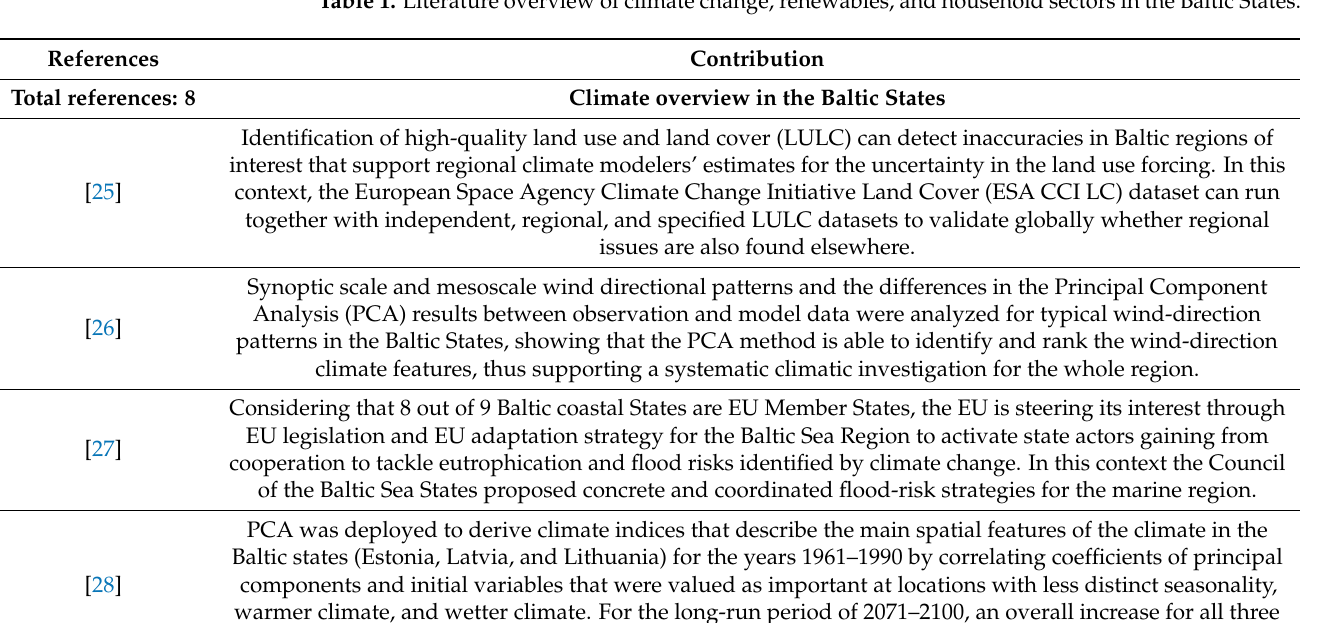
Table 1. Literature overview of climate change, renewables, and household sectors in the Baltic